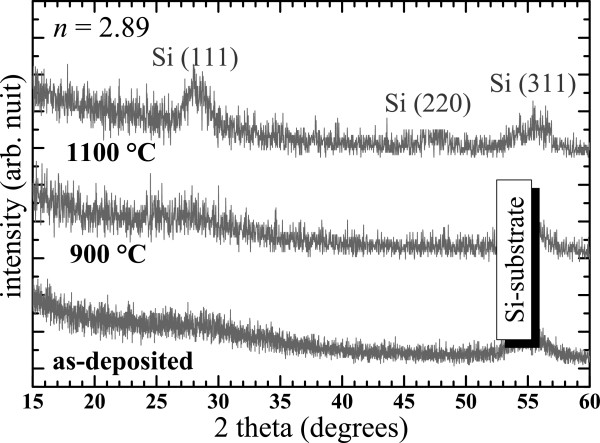
Evolution of the XRD pattern of a SiNxlayer as a function of the annealing temperature.